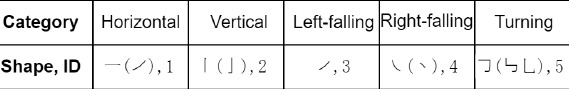
Figure 3. Five basic categories of strokes.